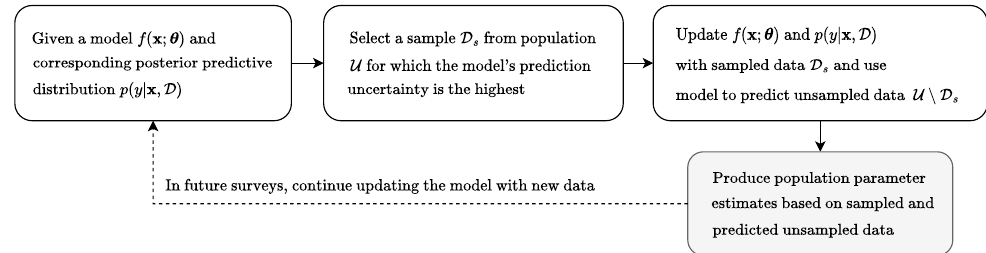
Figure 3. Process flow chart of the proposed BMVI sampling